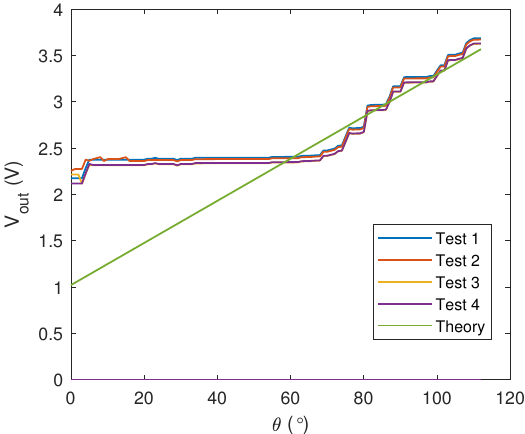
Figure 4. Comparisons between real and theoretical sensor output voltages with respect to the bending